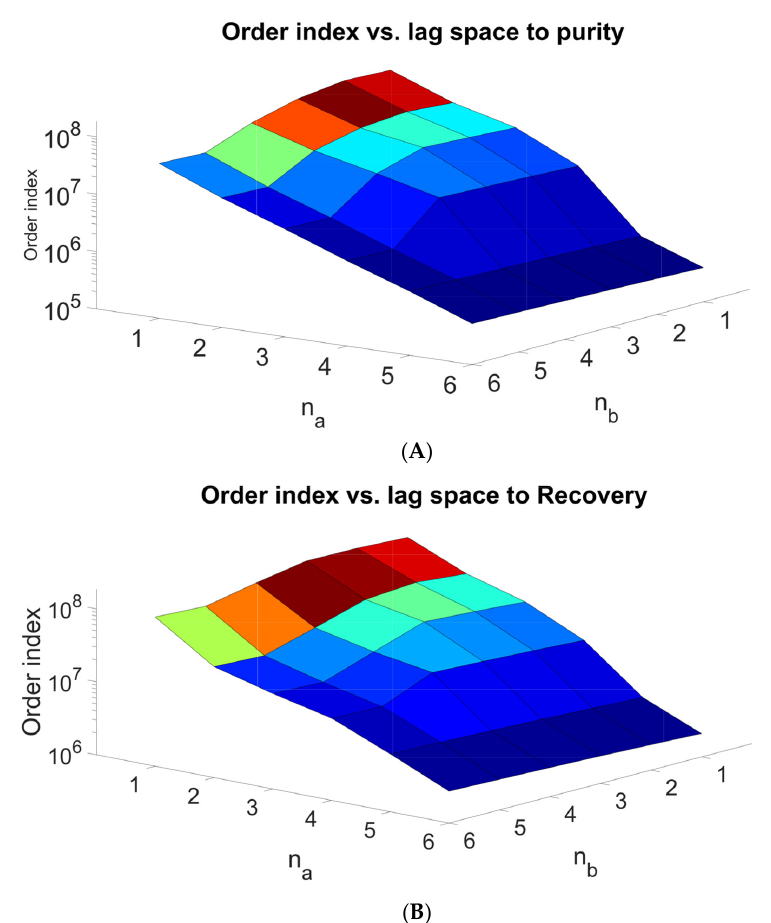
Figure 5. Lipschitz indexes for process inputs in order of the recovery ( A ) and purity ( B ), 𝑛 (cid:3028) and 𝑛 (cid:3029) are the number of past values for the output and input, respectively, as in Equations (3) and (4).